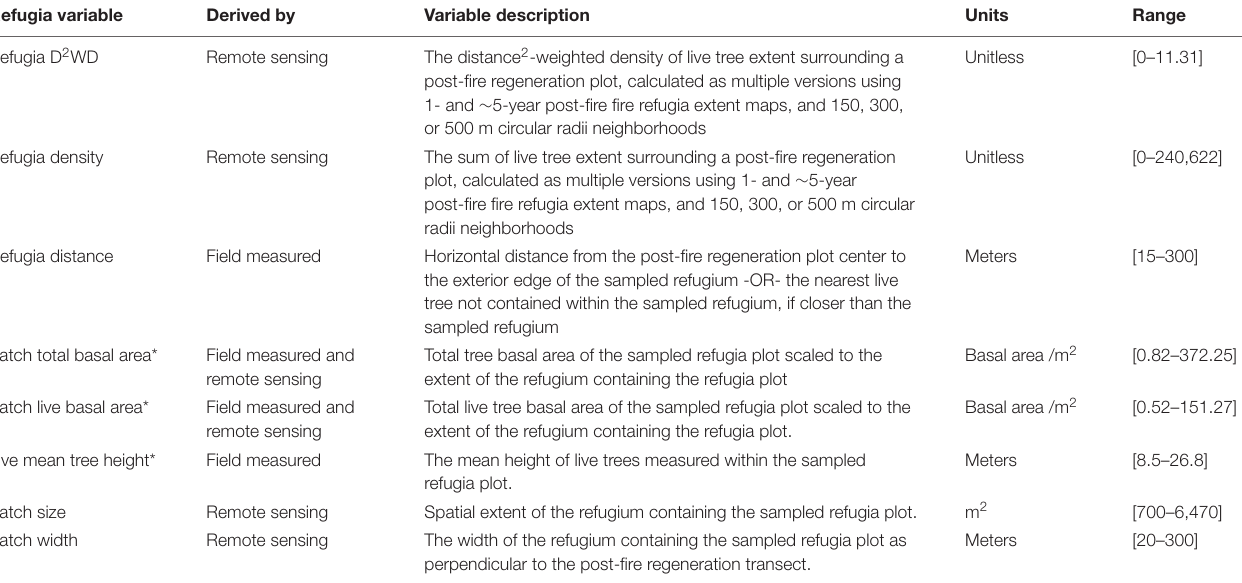
TABLE 1 | Patch- and neighborhood-scale predictive variables associated with spatial, structural, and temporal attributes of fire refugia, as derived by field measurements, remote sensing, or both sources. Refugia